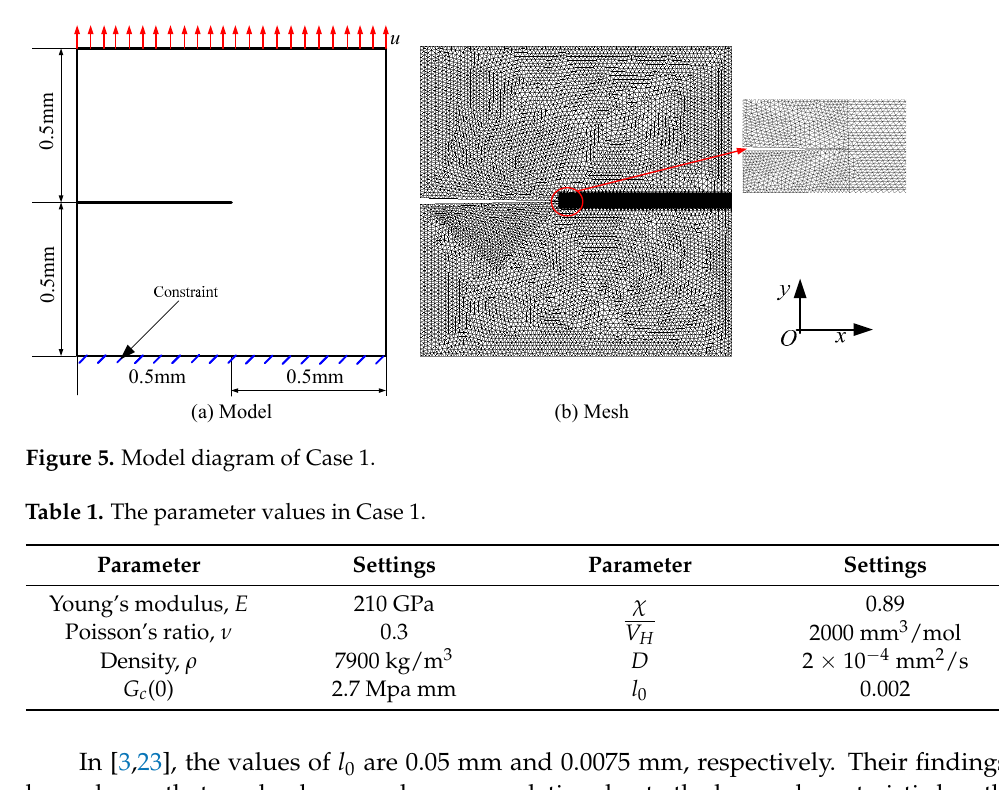
Figure 6. Load-displacement curves with different hydrogen concentrations.